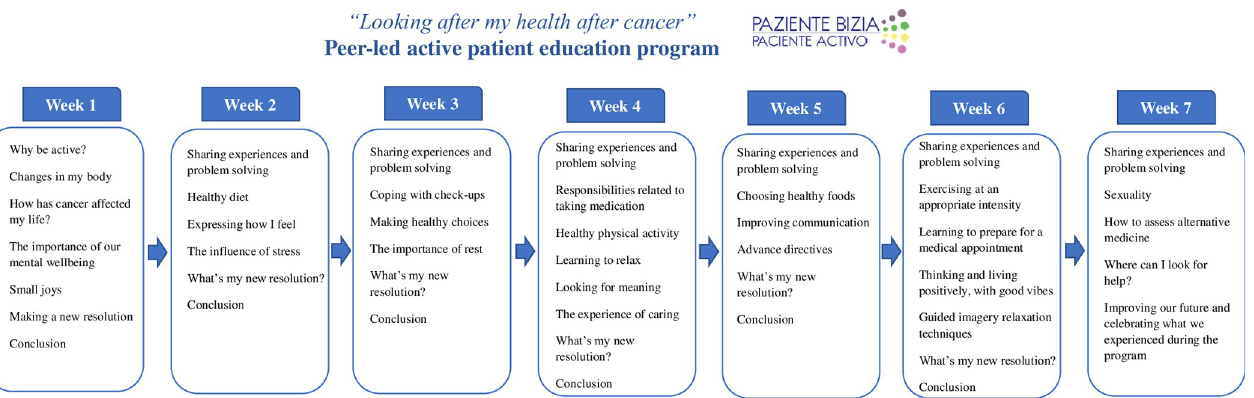
PLOS ONE | https://doi.org/10.1371/journal.pone.0282018 February 24,